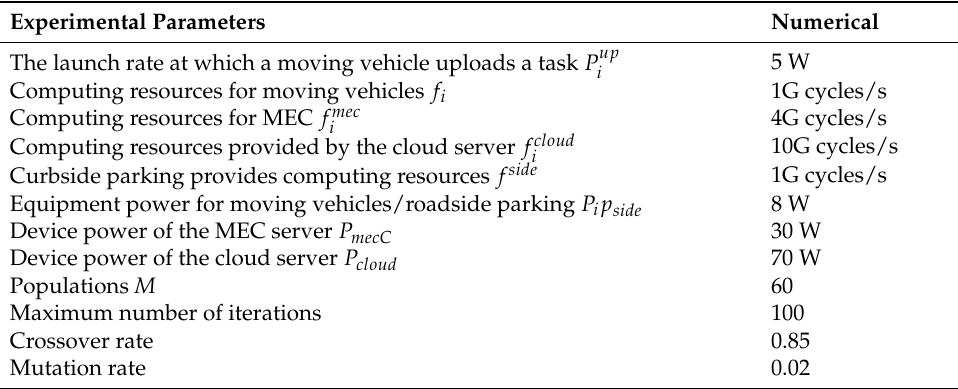
Table 1. Simulation experiment parameters. Experimental